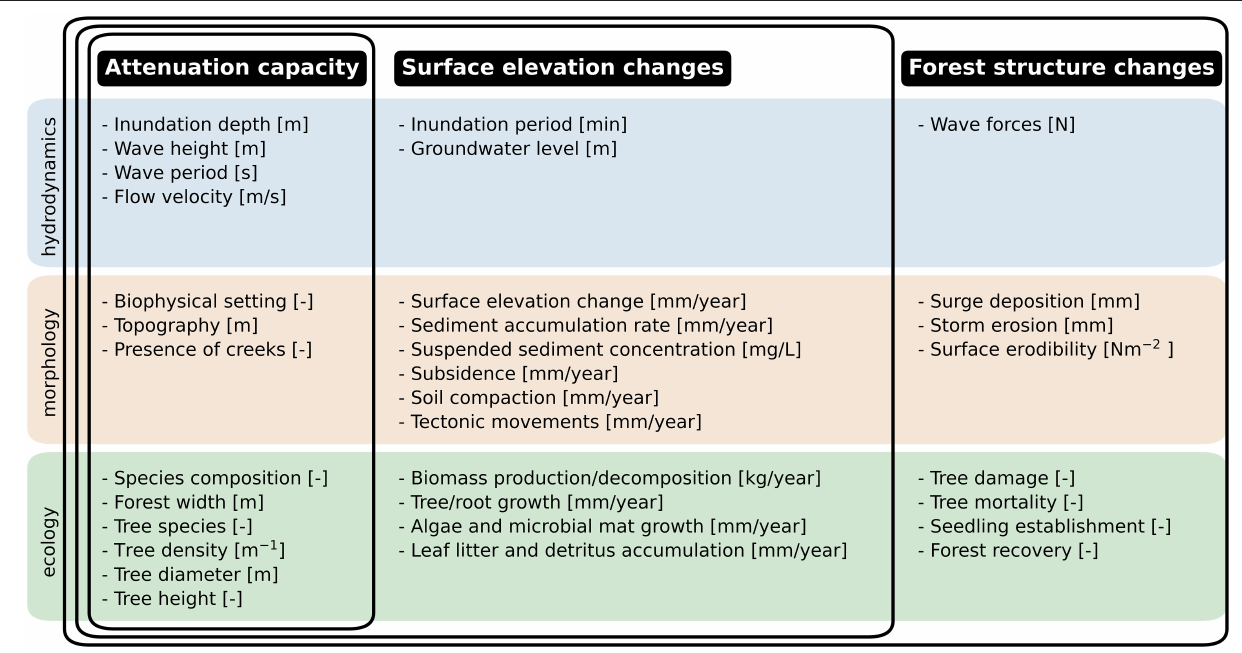
FIGURE 3 | Hydrodynamic, morphological and ecological parameters of processes that determine the functionality and persistence of mangroves. The overlapping frames indicate which parameters are included for the attenuation capacity, surface elevation changes and forest structure changes, respectively.